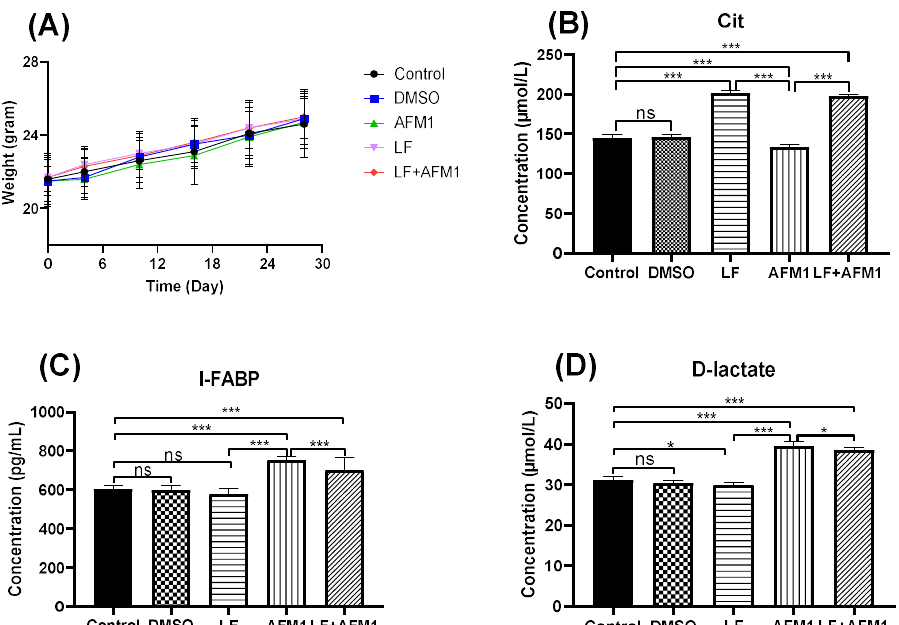
Figure 1. The effects of LF and AFM1 on mice body weight ( n = 10 animals) and serum indicators. ( A ) Body weight, ( B ) Cit, ( C ) I-FABP and ( D ) D-lactate. Control represents the mice fed with physiological saline. DMSO represents the mice fed with the solution of 1% DMSO/99% corn oil. AFM1 represents the mice exposed to individual AFM1. LF represents the mice exposed to individual LF. LF + AFM1 represents the mice exposed to combined LF and AFM1. Values represent the mean ± SEM. * represents p < 0.05, *** represents p < 0.001.